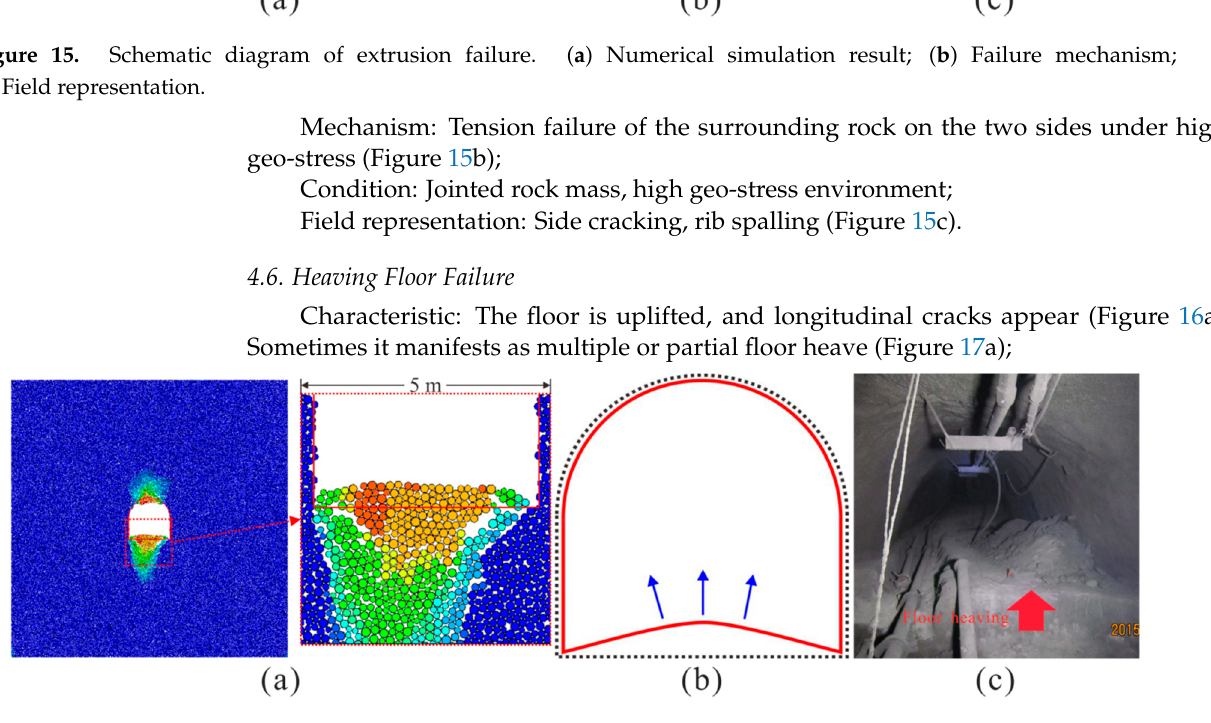
Figure 16. Schematic diagram of heaving floor failure. ( a ) Numerical simulation result; ( b ) Failure mechanism; ( c ) Field representation.